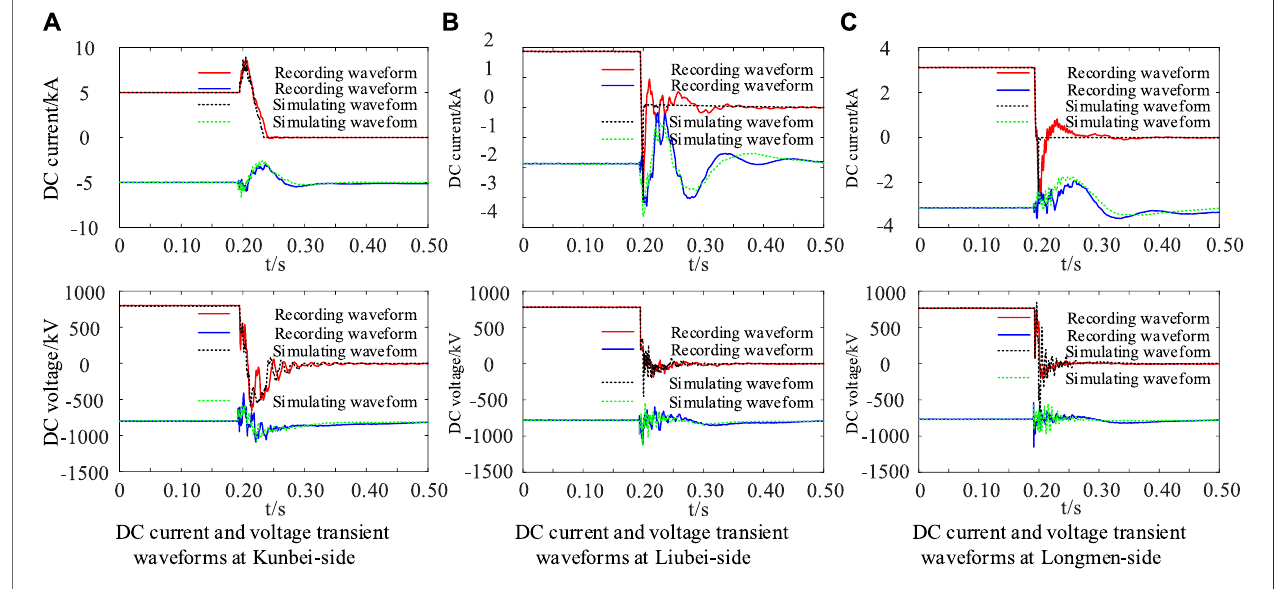
FIGURE 14 | Comparison of transient waveforms at the positive electrode 25% of the DC line from Liuzhou to Longmen.